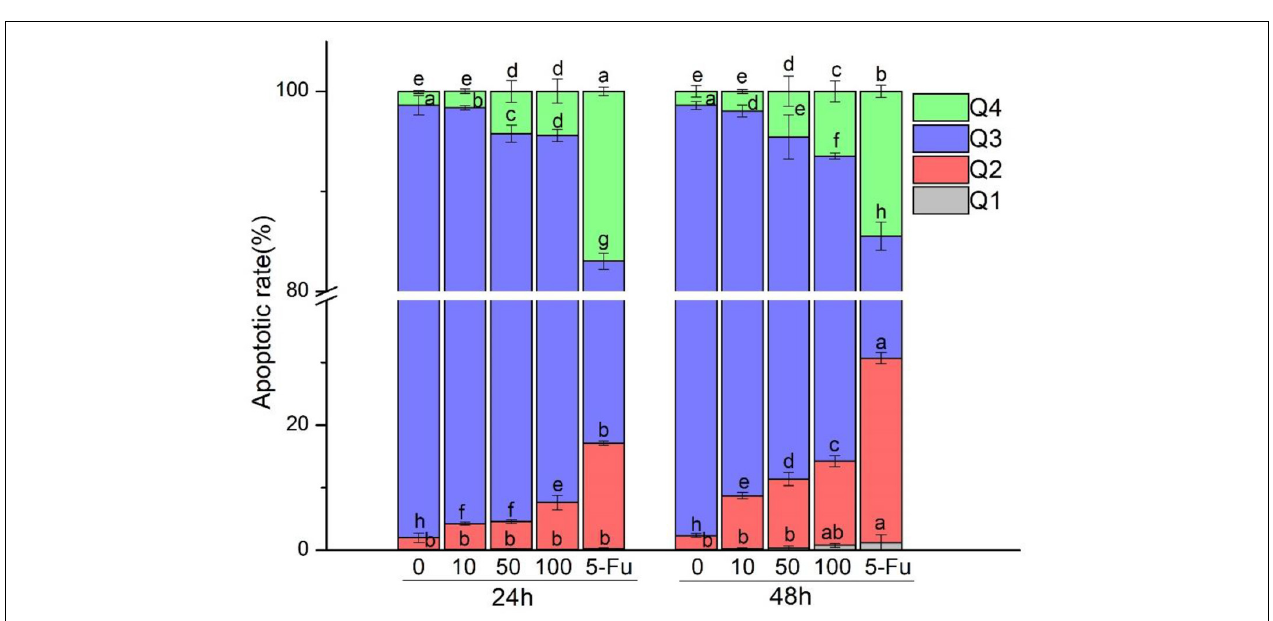
FIGURE 2 | Morphological features of the HT-29 cells treated with L. acidophilus KLDS1.0901 of different MOI (0, 10, 50, and 100) and 5-FU (100 µ mol/L) for 24 h (A–E) and 48 h (F–J) . A fluorescence microscope was used to photograph images (20 × ). The red and green arrows indicate the corresponding apoptosis and intact cells.